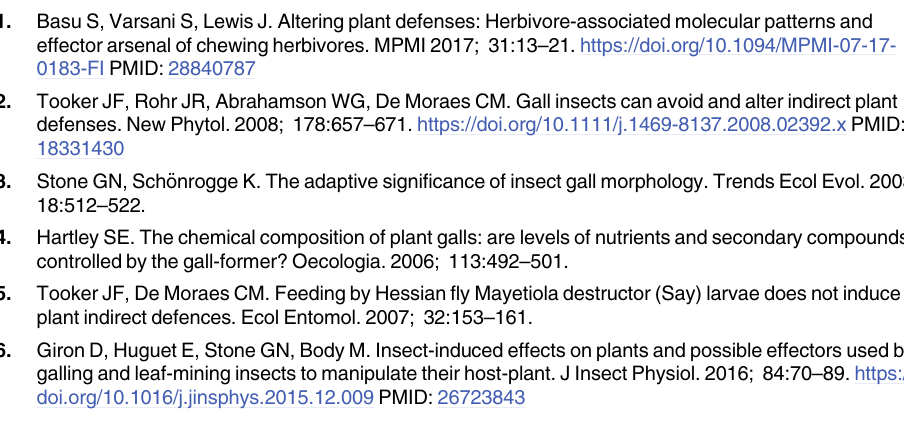
S1 Table. Summary statistics (Mean, standard deviation, minimum, and maximum) for functional traits used in the chemometric modelling. LMA, leaf mass per area; GA, gallic acid equivalents; SD, standard